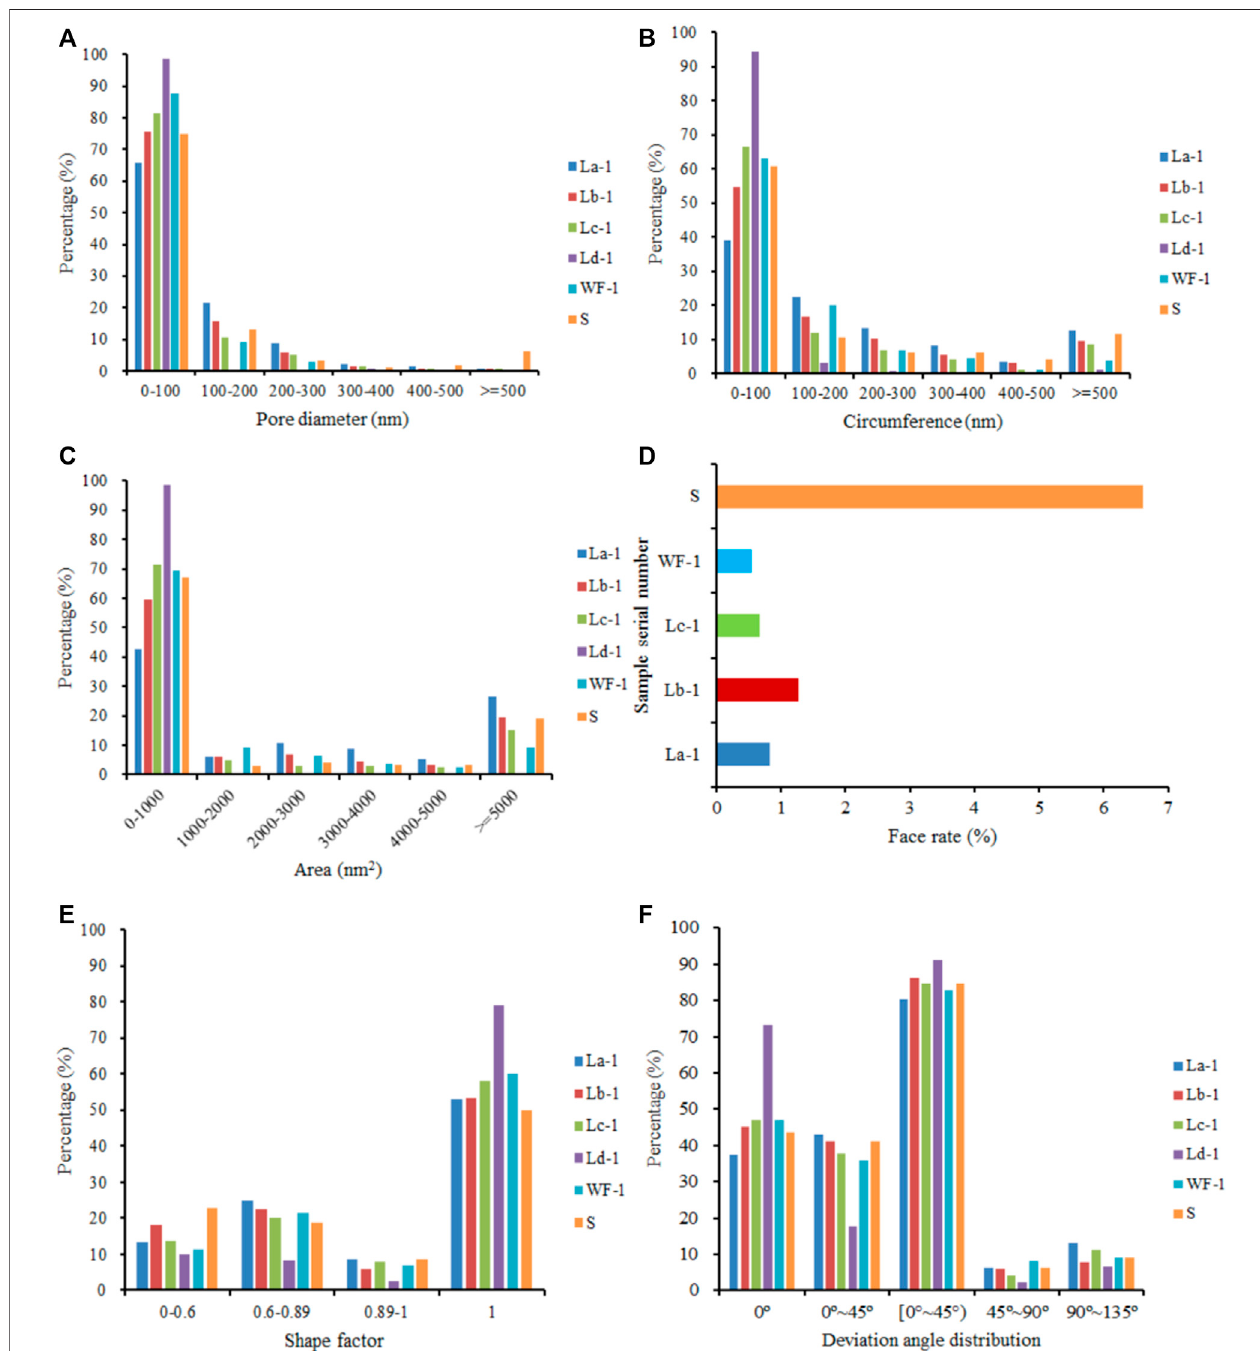
FIGURE 4 | Distribution characteristics of pore structure parameters of shale samples. Notes: (A) Pore diameter distribution; (B) Pore circumference distribution; (C) Pore area distribution; (D) Face rate distribution; (E) Shape factor distribution; (F) Deviation angle distribution.